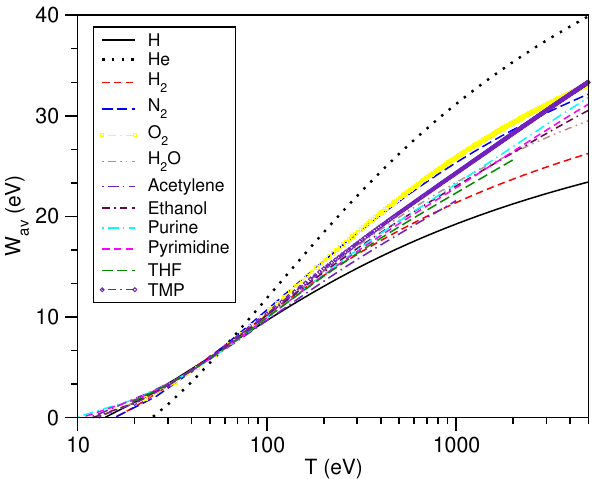
Figure 15. W av for targets discussed throughout this